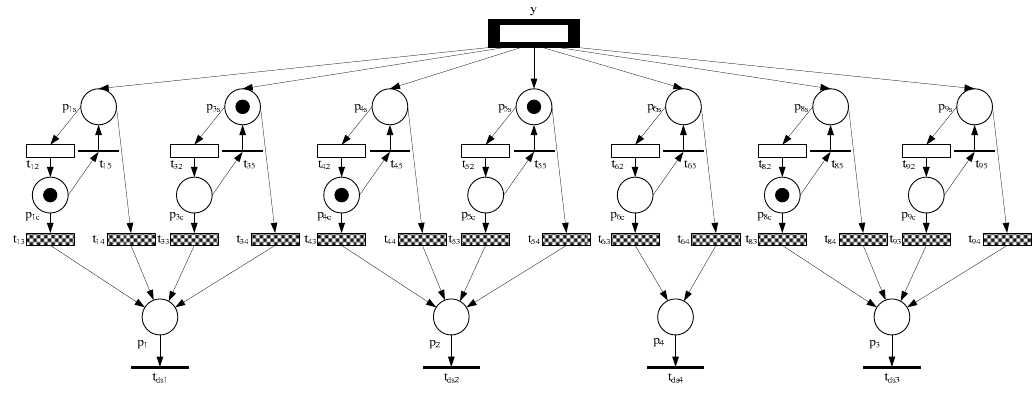
Figure 10. PN model for the case study. Table 1. Initial state for the charging